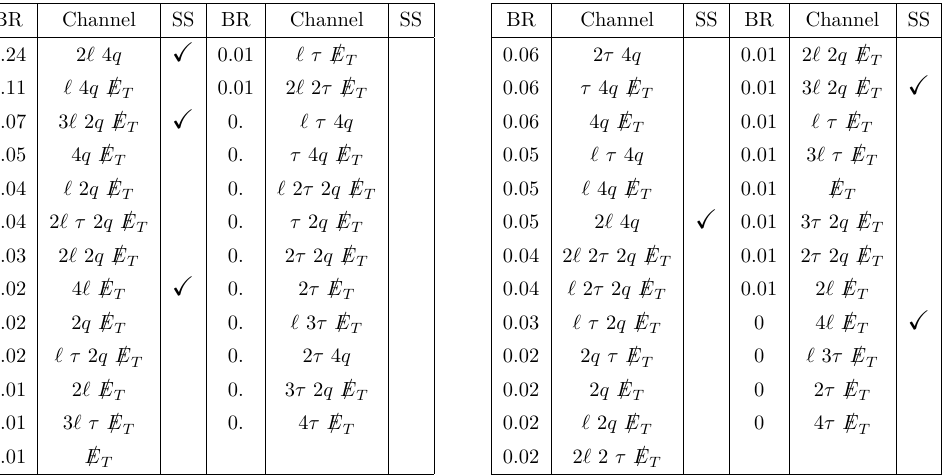
Table 4 . Decay rates from NN production for BP1 IH (left) and BP2 IH (right). The rates are obtained by summing on all charges and flavor configurations. Here ‘ = e, µ . The checkmarks correspond to channels that can produce a SS lepton